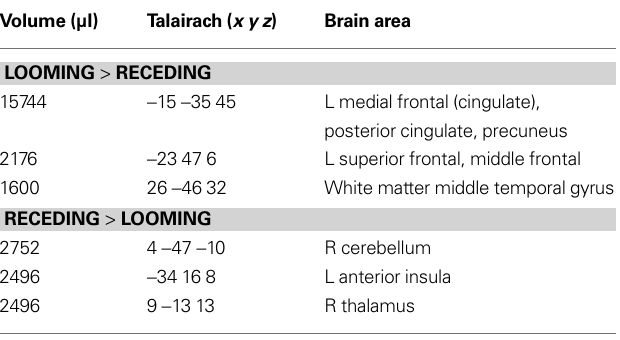
Table 4 | LOOM > RECEDE, RECEDE > LOOM. Regions of signifi cant activation ( P < 0.05, corrected) for the contrast looming > receding signal and receding > looming signal.